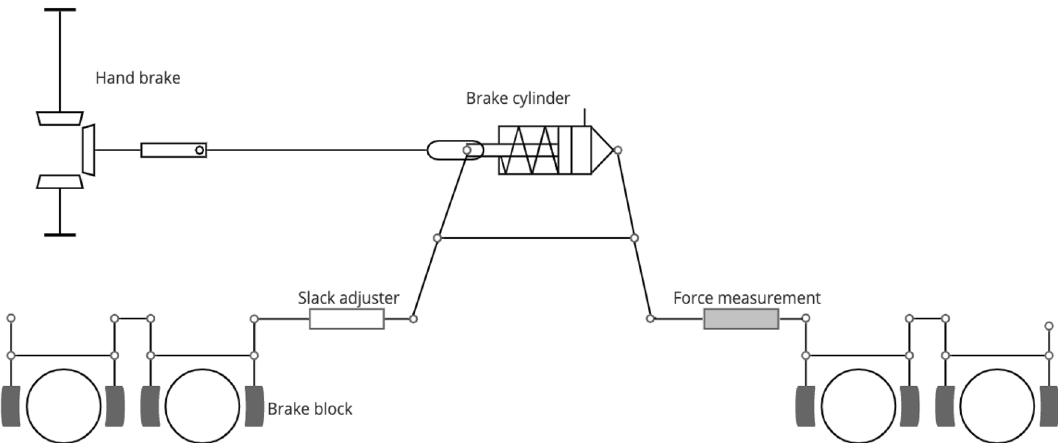
Fig. 4 Instrumented brake